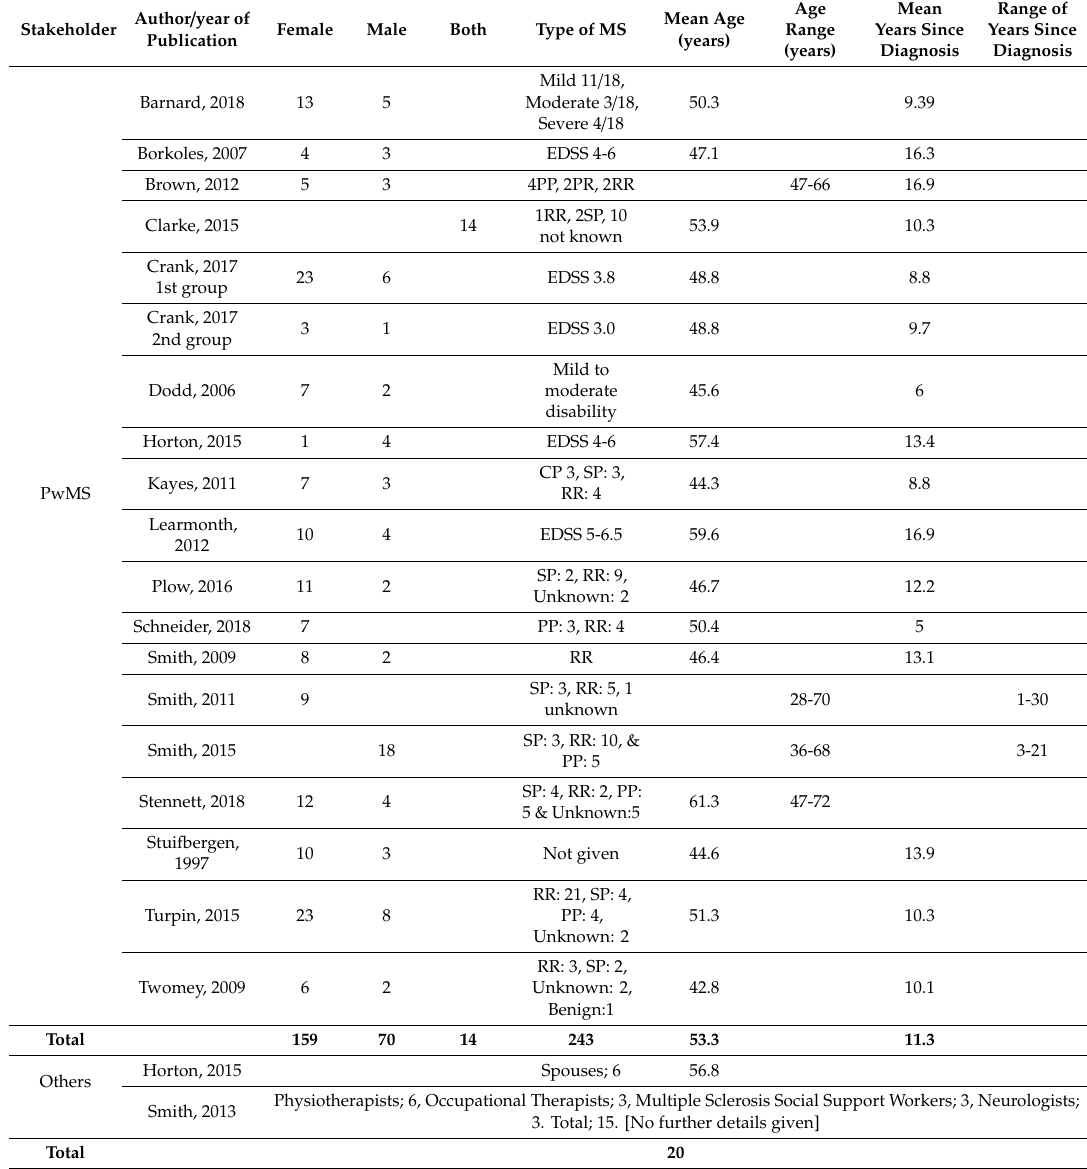
Table 1. The Demographic Information of studies’